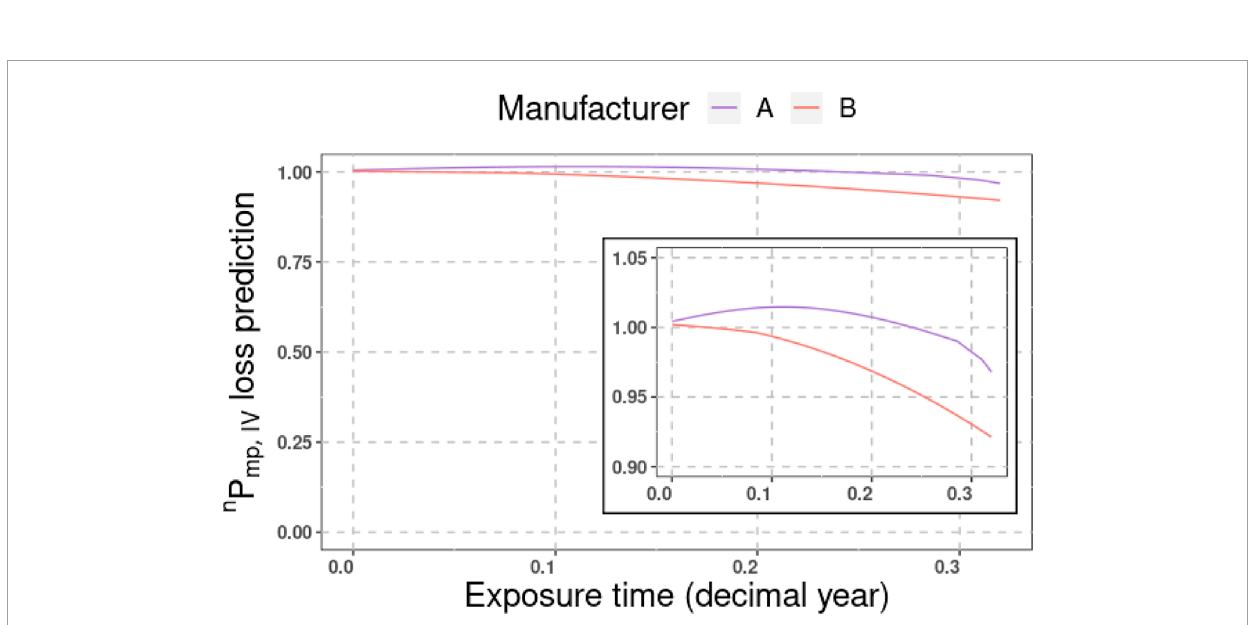
FIGURE 10 Service lifetime prediction plot comparing GB with EVA in mDH manufactured by A and